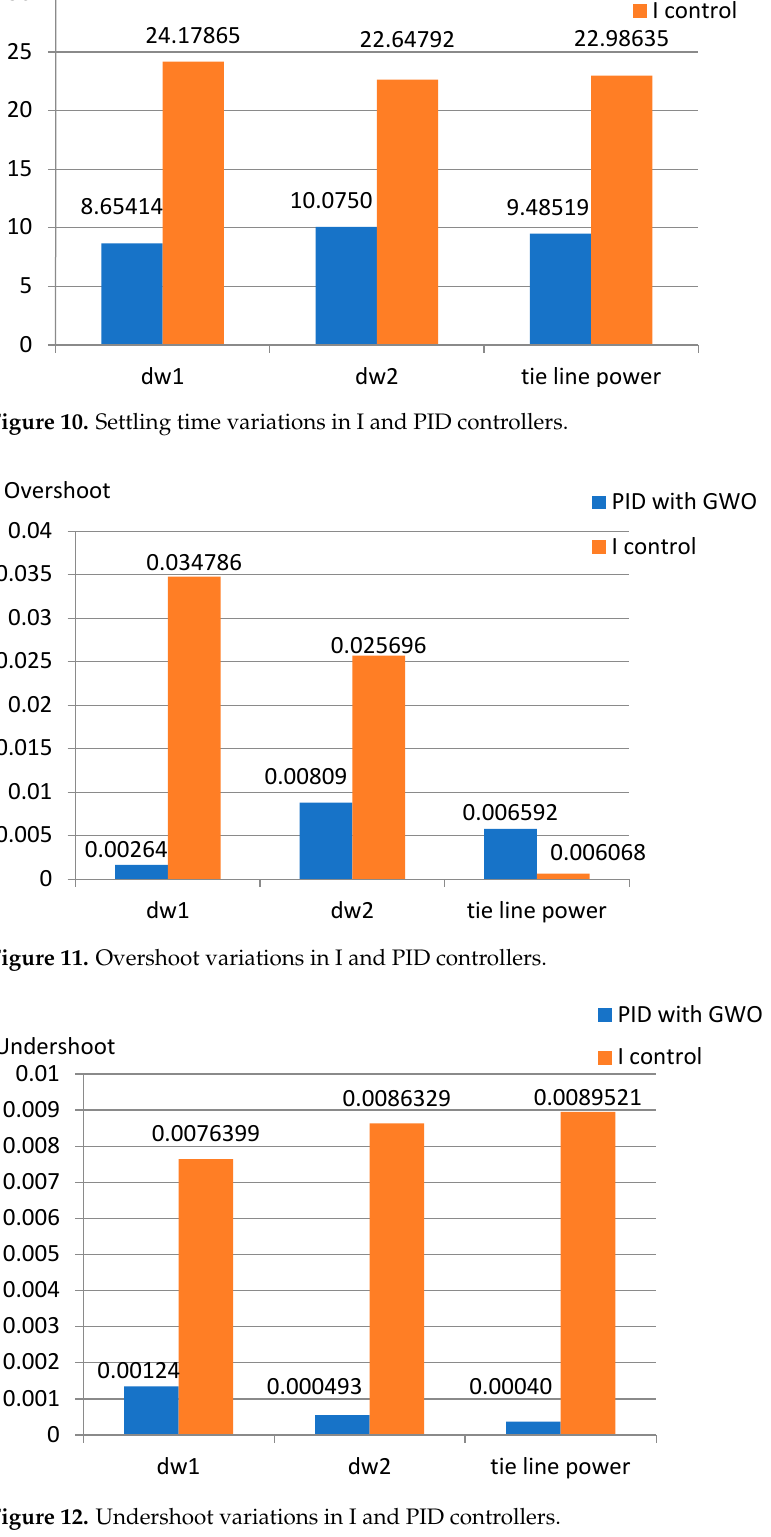
Figure 12. Undershoot variations in I and PID controllers.